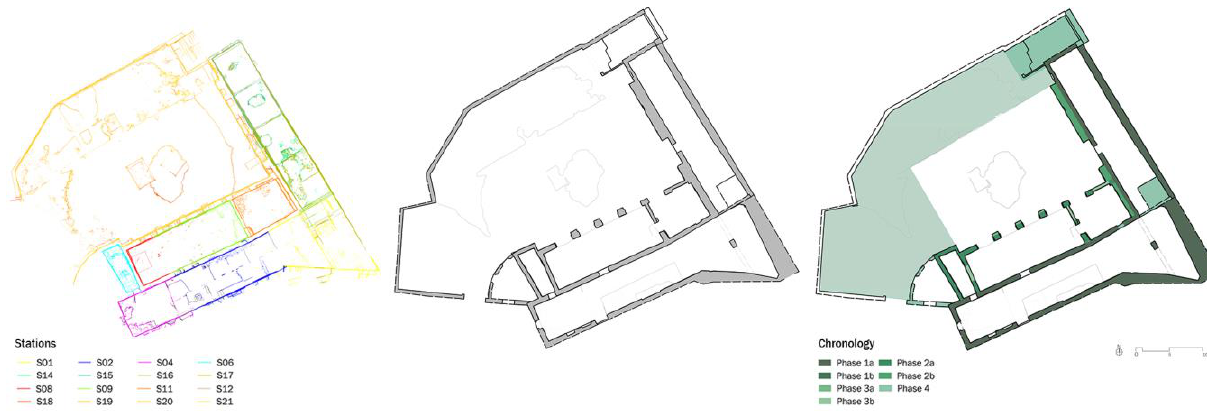
Figure 5. a) Map of the 10 main significant plan sections used to draw the plan b); c) summary of chronologies (research and graphic elab.: Pilia